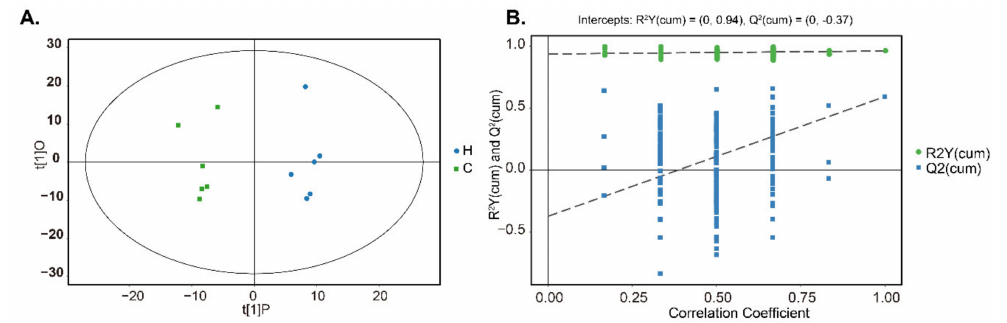
Figure 4. Orthogonal partial least squares discriminant analysis [(O)PLS-DA] plots of rumen metabolites between Groups C and H. Score scatter plot of OPLS-DA model for Group H versus C (A) . Permutation test of OPLS-DA model for Group H versus C (B)